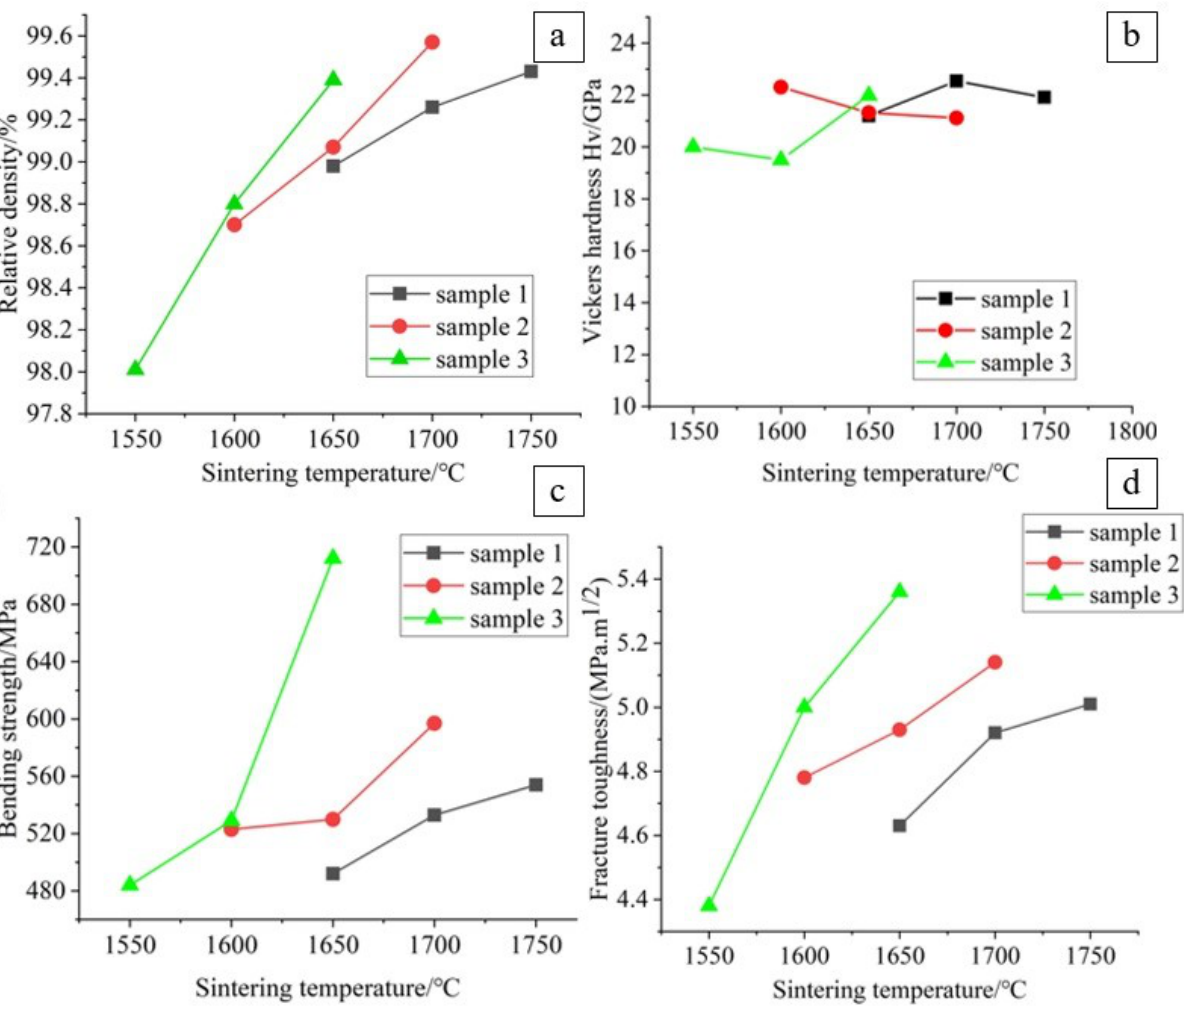
Figure 4: Variation law in the properties of Al 2 O 3 –TiC composites with sintering temperature [24] (a) Variation law of relative density with sintering temperature, (b) Variation law of Vickers hardness with sintering temperature, (c) Variation law of bending strength with